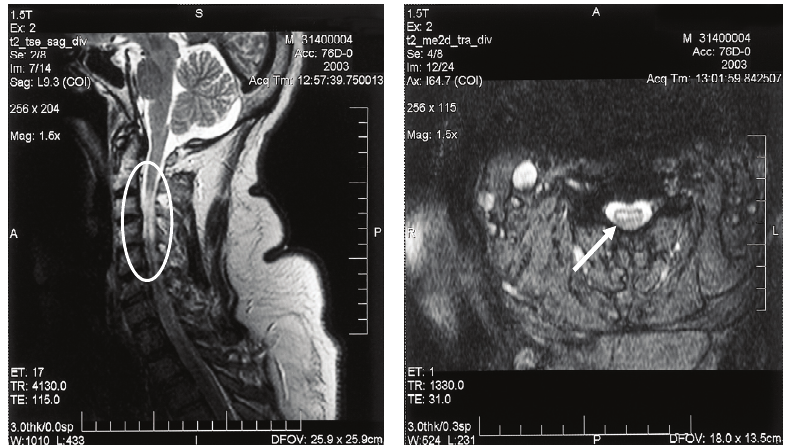
Figure 3. Sagittal ( A ) and axial ( B ) T2-weighted magnetic resonance imaging of the cervical spinal cord of a patient with bilateral upper extremity paralysis and respiratory failure from West Nile poliomyelitis, displaying the increased signal in the anterior spinal cord (circle and